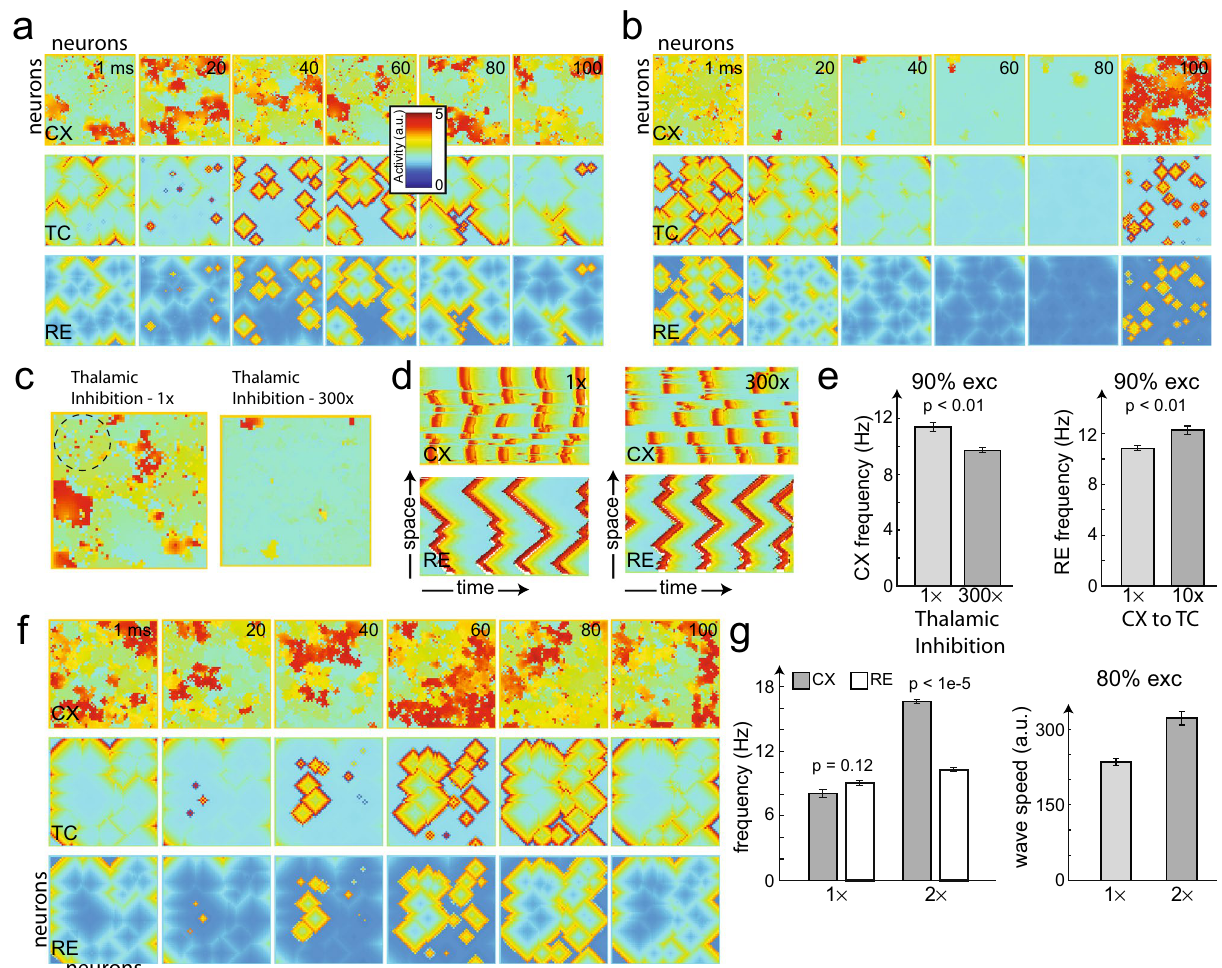
Figure 6. Cortical and thalamic E/I balance alters traveling wave speed and frequency. ( a ) The spatiotemporal activity produced by a closed-loop 2D thalamocortical network (10% TH CX connectivity, fully connected CX → with 90% excitatory neurons). Each panel shows the 60 60 neuron array layout and colors denote activity levels. × ( b ) Spatiotemporal activity obtained with the same setting as a, but with RE inhibition increased. ( c ) Repeated cortical cell firings occurred due to TC excitatory inputs (dots in the dashed black circle). These dots propagated as a traveling wave. Triggering dots reduced/absent when RE inhibition increased. ( d ) 1D projections of waves from the two scenarios. ( e ) (left) Comparison of the cortical oscillation frequency between two levels of RE inhibition ( 1 vs. 300 ). (right) Comparison of the thalamic oscillation frequency between two levels of × × CX TC excitation ( 1 vs. 10 ). All error bars represent SEM. ( f ) Traveling waves induced by increased CX → × × excitatory weights (10% TH CX connectivity and 99% intracortical connectivity with 80% excitatory neurons). → As seen in space-time projections, wave activity was significantly increased (in comparison with Fig. 1d). ( g ) Cortical wave frequency and speed increased as the CX excitatory weights were multiplied by two folds ( p values obtained from five simulations, Student’s t